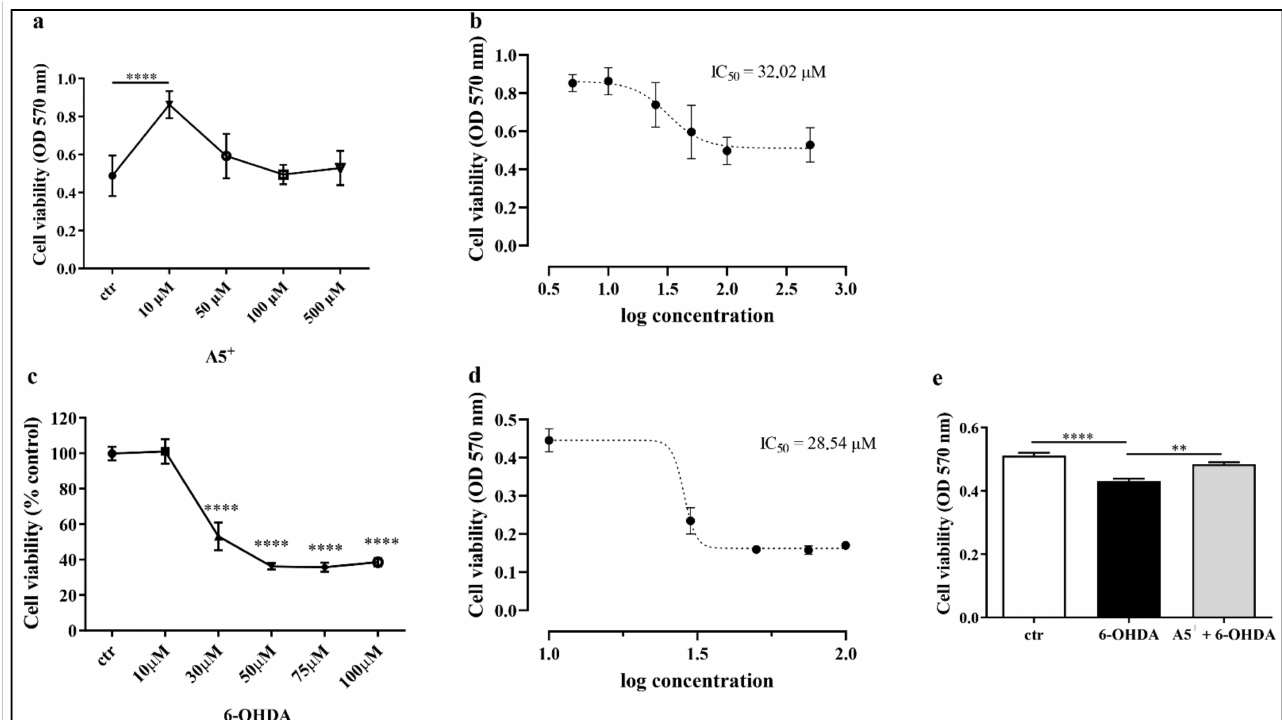
Figure 1. Cell viability assessment following A5 + and/or 6-OHDA administration. ( a ) Cell viability assessment following different concentrations of A5 + administration; ( b ) IC 50 related to A5 + . ( c ) Cell viability assessment following different concentrations of 6-OHDA administration; ( d ) IC 50 related to 6-OHDA. ( e ) Cell viability following 6-OHDA (black bar) or A5 + + 6-OHDA (grey bar) administration. Data are reported as mean ± SEM ( n = 4). (** p < 0.005; **** p < 0.0001). ctr: control; 6-OHDA: 6- hydroxydopamine; OD: optical